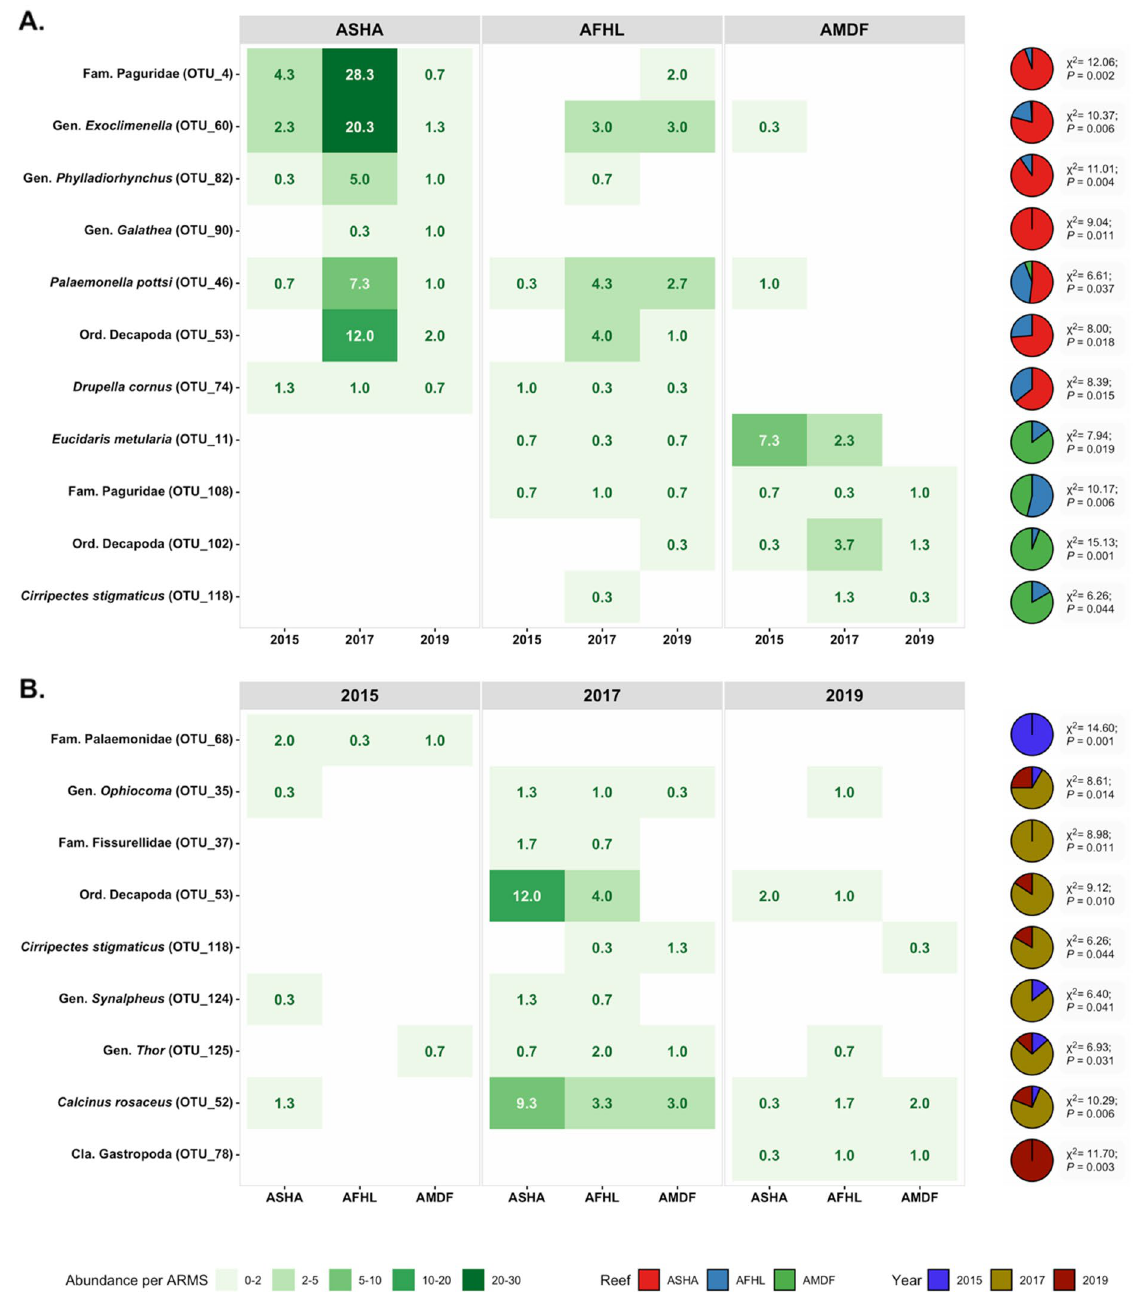
Figure 5. Average abundances per ARMS of the indicator taxa observed for the barcoding fraction by reef ( A ) and sampling year ( B ). Kruskal–Wallis test results are shown in the right side. ASHA Abu Shoosha reef, AFHL Al Fahal, AMDF Abu